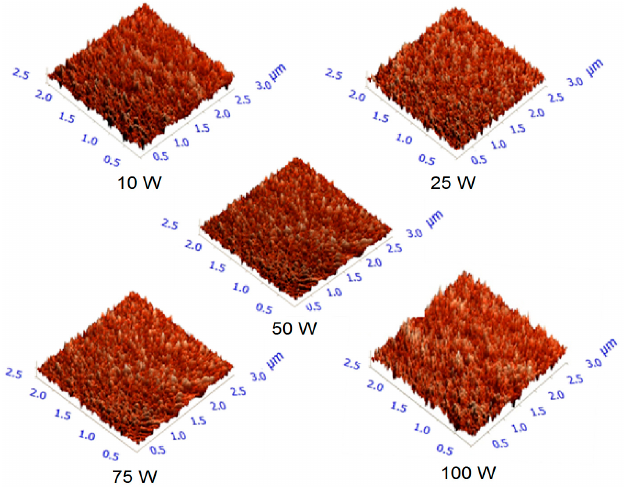
Figure 5. Typical three-dimensional atomic force microscope images of 3 µm × 3 µm scanning area of geranium oil-derived film surfaces fabricated at various RF power. Table 3. Surface profiles of 3 µ m × 3 µ m and 10 µ m × 10 µ m of geranium oil-derived film surfaces fabricated at various RF